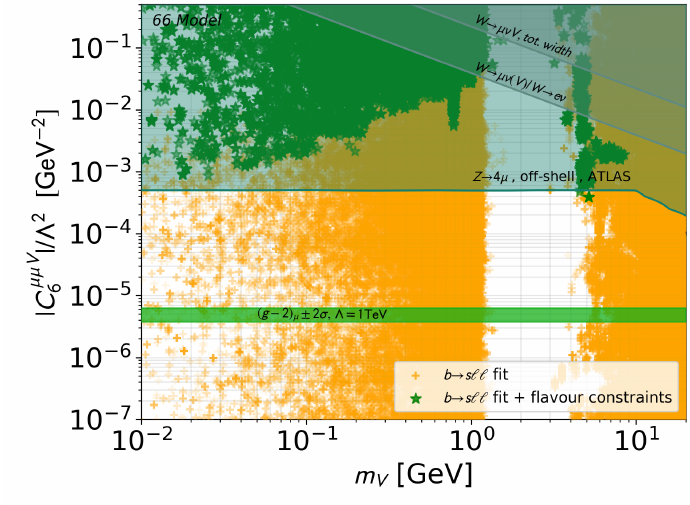
Figure 4. Constraints on the parameter space consistent with the LFUV anomalies (yellow points) in the plane of C µµV versus the vector mass m V for the 66 model. The colour scheme is the same 6 as in figure 3. The position of the ( g − 2) µ 2 σ band corresponds to a UV scale Λ = 1 TeV , see eq.